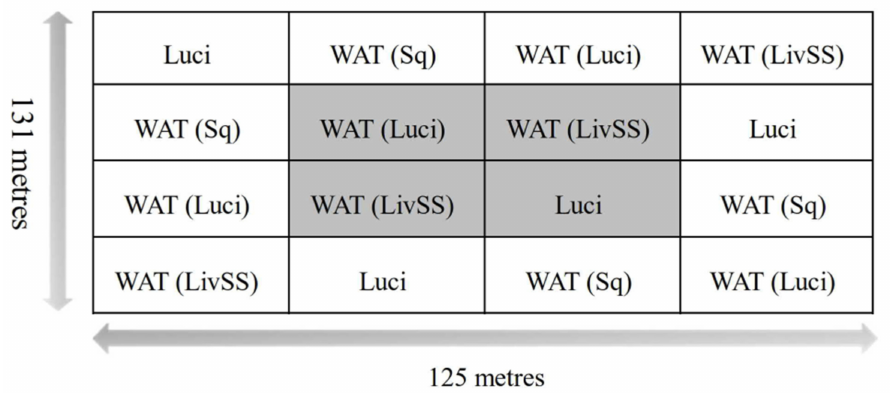
Figure 1. Outline of the four-by-four orthogonal Latin square array study design. LuciTrap with LuciLure A, B and C (Luci); Western Australian Trap with squid (WAT (Sq)), Western Australian Trap with LuciLure A, B and C (WAT (Luci)); and Western Australian Trap with sheep liver and sodium sulphide (WAT (LivSS)). Grey shading designates the inner portion, while the white background designates the outer portion of the trapping study